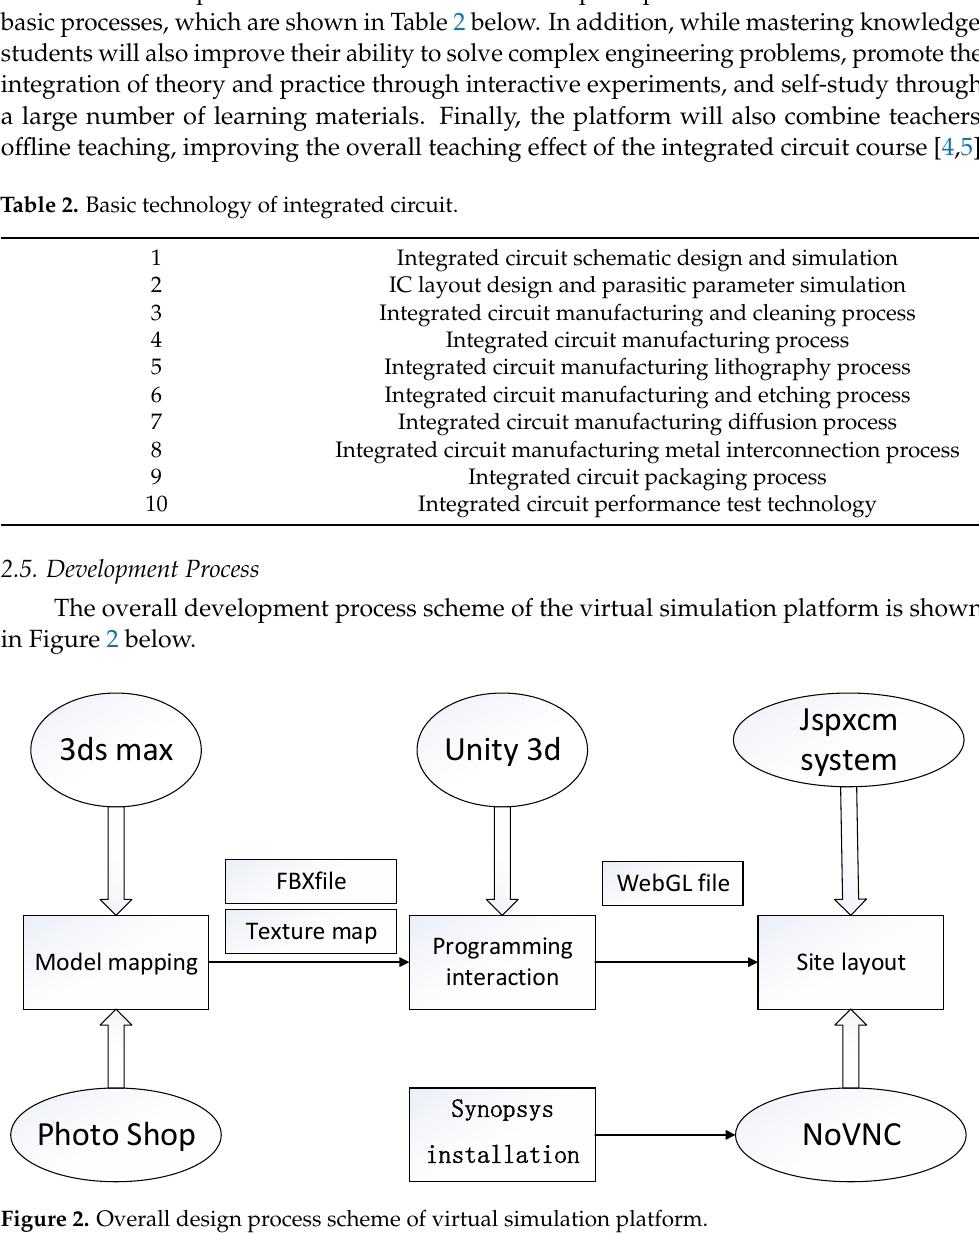
Figure 2. Overall design process scheme of virtual simulation platform.